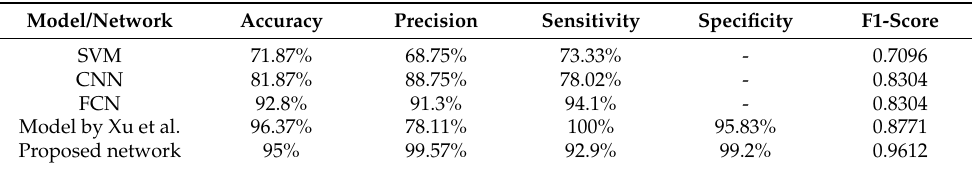
Table 9. A comparison of several methods on image